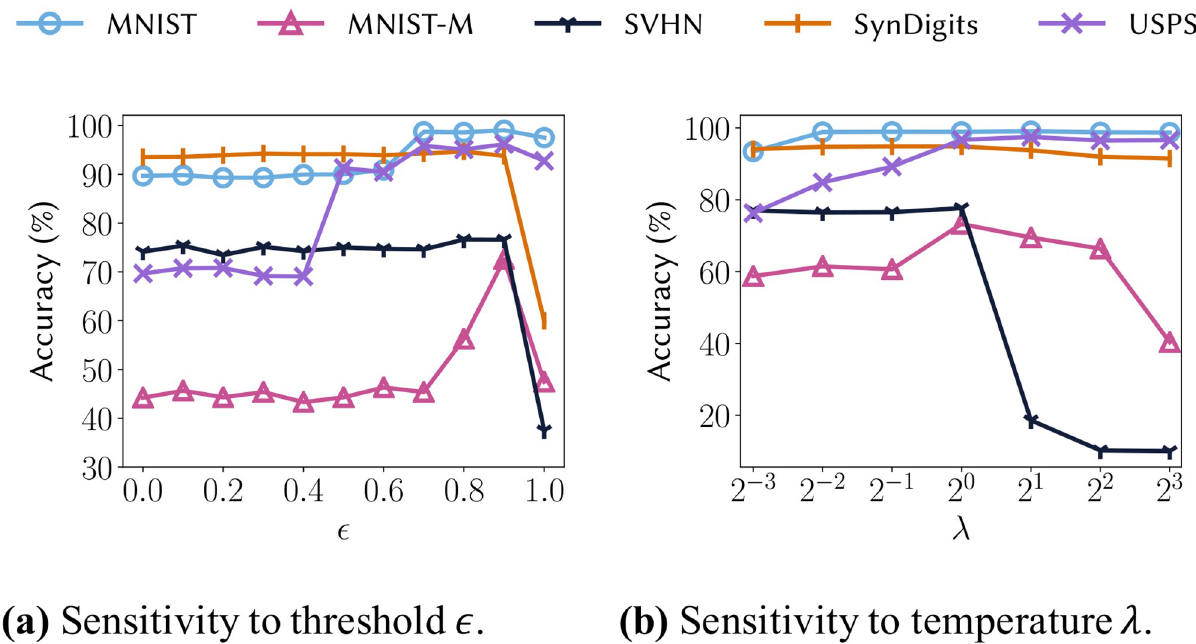
Fig 6. Sensitivity of accuracy to the hyperparameters � (Eq 10) and λ (Eqs 2 and 6).